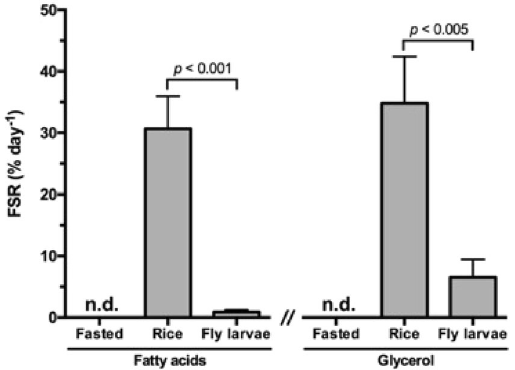
Figure 3. Triglyceride-bound fatty acid and glycerol fractional synthetic rates (FSR) expressed as percent per day of subcutaneous fat triglycerides from black-tailed godwits submitted to three different diets (Fasted, Rice and Larvae) and to 2 H 2 O administration for 24 h. Mean values ± SEM are presented (n = 7 for Fasted and Rice; n = 8 for Larvae). No labelling detected in fasted birds: n.d. Differences between dietary treatments are indicated (t-test, p <